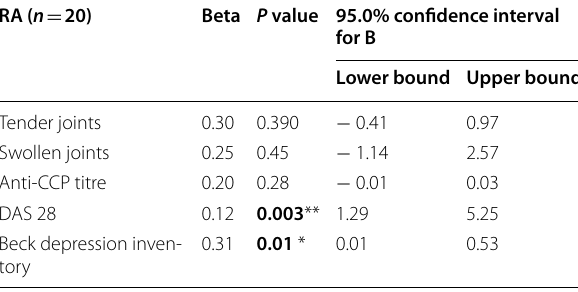
Table 5 Regression analysis for the prediction of the Athens Insomnia scale grading in RA patients